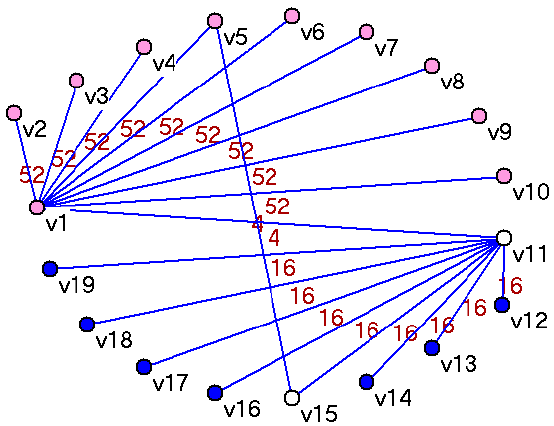
Figure 6. The k-core decomposition of the SCSG graph representing the 19 files in Table 1 using STAR topology. There are three k-cores: the coreness of ten “red” vertices is 52 bytes, of the two “white” vertices is 20 bytes and of the seven “blue” vertices is 16